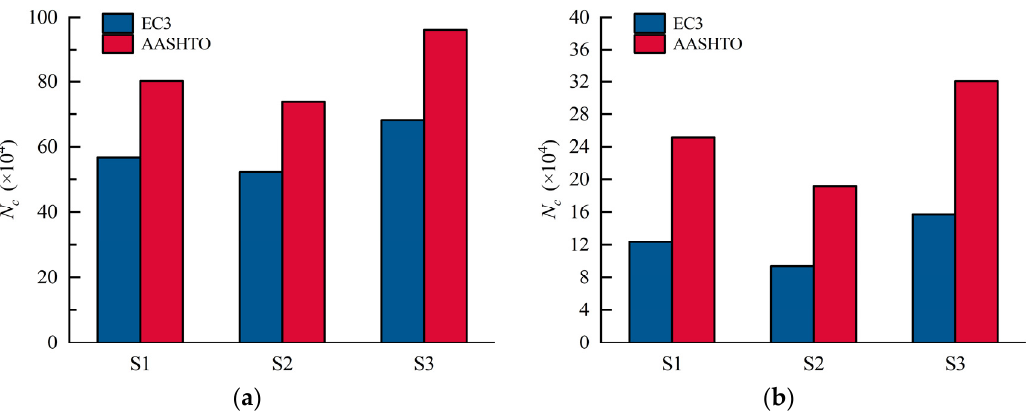
Figure 21. Fatigue lives of S1, S2, and S3 in different codes: ( a ) detail 2; ( b ) detail 4.